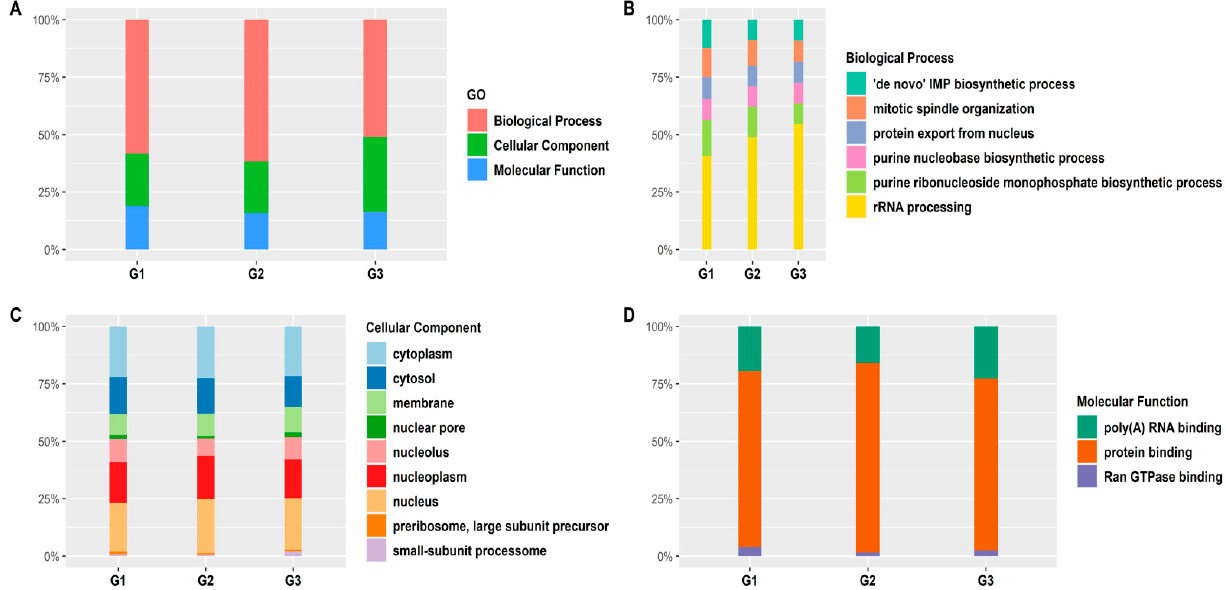
Figure 3. Functional group enrichment analysis of UR RRA genes in G1, G2, and G3. ( A ) Analyses of GO functional groups within G1, G2, and G3. The Y-axis of these 100% stacked columns shows the percentage of genes that fall within each GO functional group. ( B – D ) Common GO functionalities between all groups. ( B ) GO biological processes. ( C ) Molecular functions. ( D ) Cellular components.